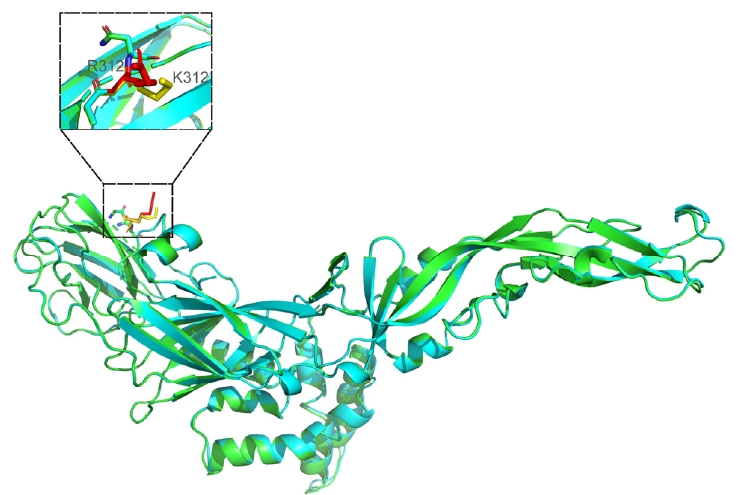
Figure 8. Display and comparison of modeled 3D structures between JEV CH/GD2011/2011 and CH/SA14-14-2 MSV/2018. The difference locus is at position 312 (green is the modeled 3D structures of vaccine strain; blue is the modeled 3D structures of CH/GD2011/2011; the different amino acids are distinguished by yellow and red: yellow for CH/SA14-14-2 MSV/2018 and red for CH/GD2011/2011.).